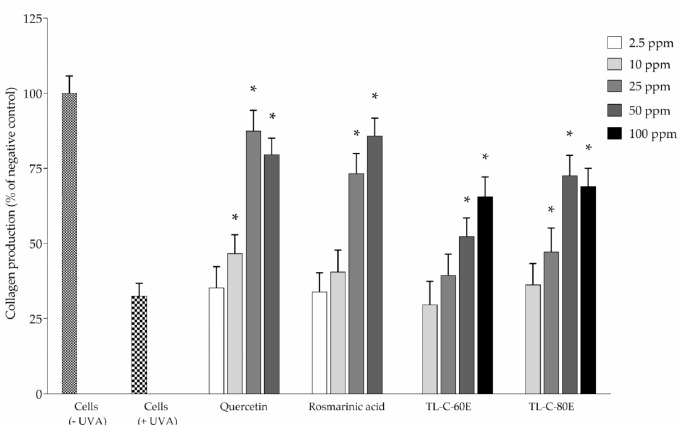
Figure 5. Inhibition effect on MMP-1 production. Data represents the mean ± SD of three indepen- dent experiments. * Indicate a significant difference of experimental samples versus treated cells with UVA irradiation ( p < 0.05).